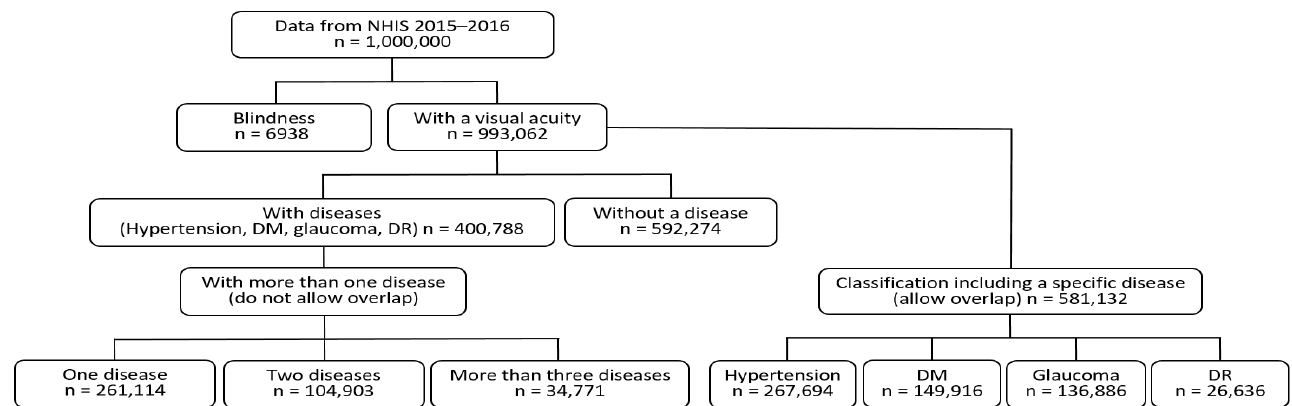
Figure 1. Flow chart of the study population. NHIS, National Health Insurance Service; DM, diabetes mellitus; DR, diabetic retinopathy.